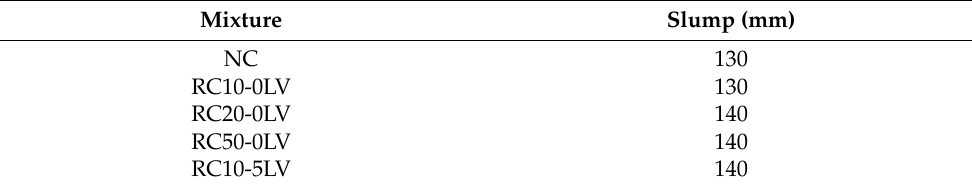
Figure 4. Slump test conventional concrete mix (NC). Table 6. Slump test results.